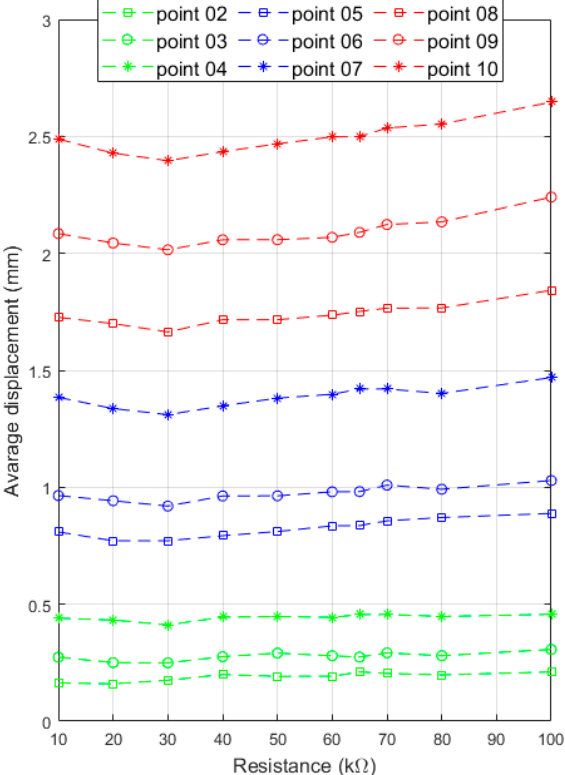
Figure 10. Comparison of average displacements of points from 2 to 10.